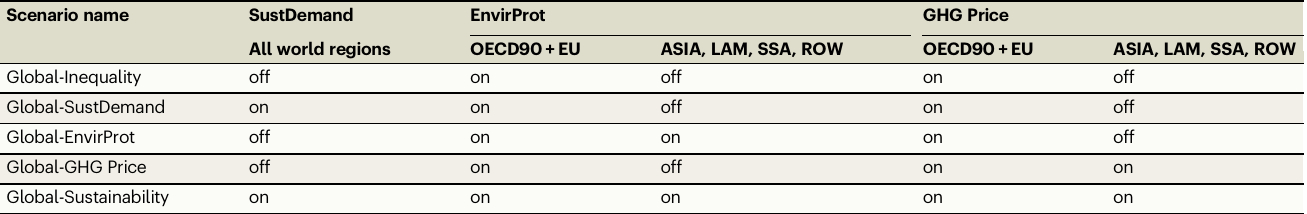
Table 4 | Scenario de fi